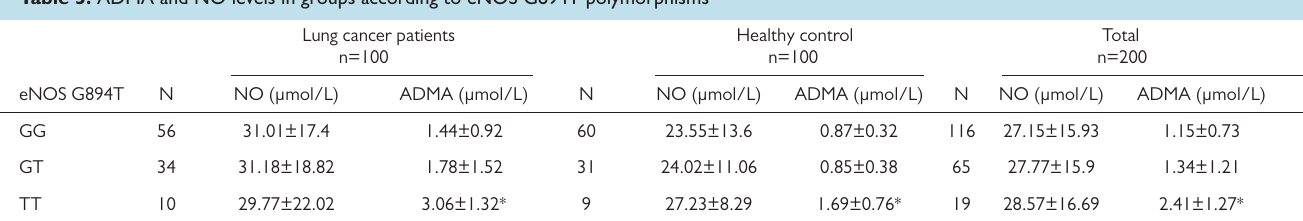
Table 5. ADMA and NO levels in groups according to eNOS G894T